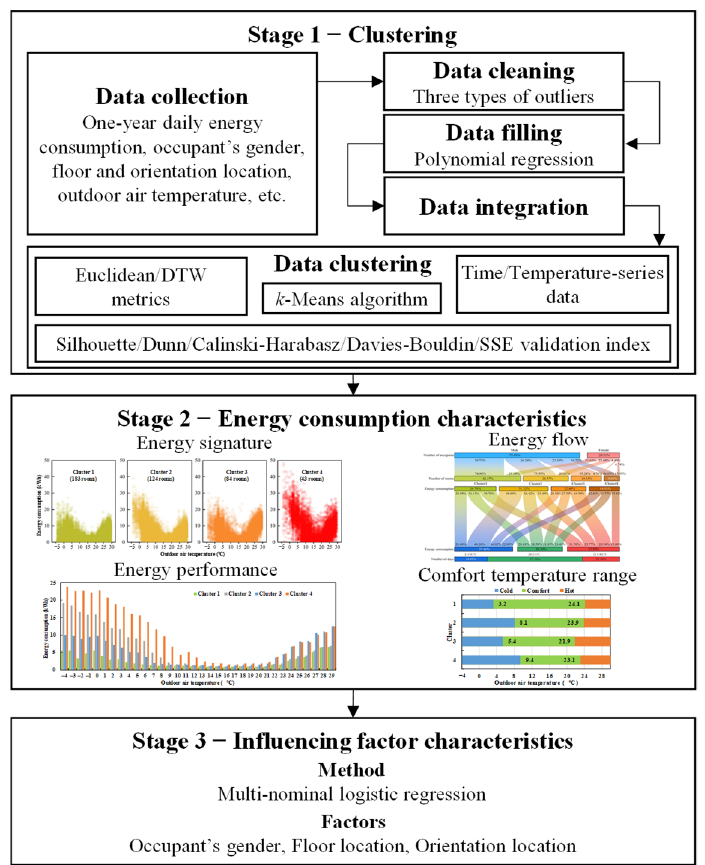
Figure 1. Steps to the proposed